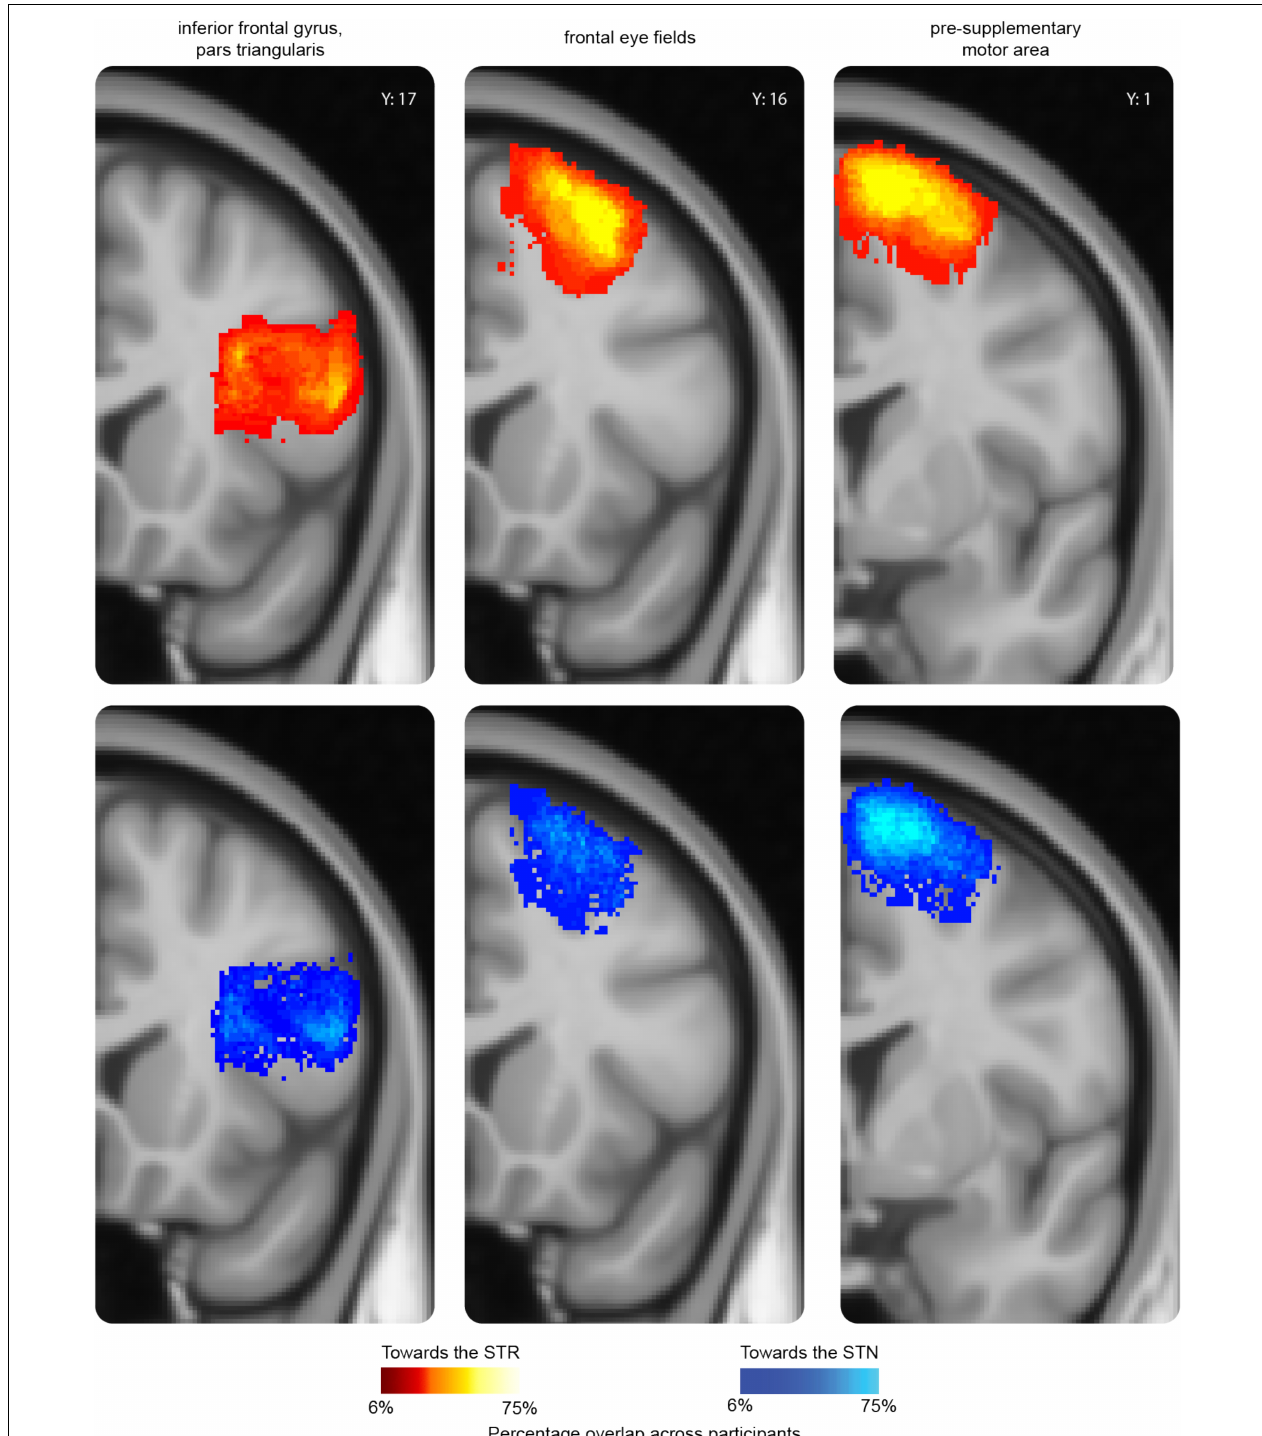
FIGURE 3 | A probability map of three representative cortical regions projecting to the subcortex. For the pars triangularis (PTR), frontal eye fields (FEF), and pre-supplementary motor area (pre-SMA), a probability map was created using the individual thresholded seed masks. The thresholded seed masks only include those voxels which contained at least 50 samples in the tractography analysis. To be able to compare the results across participants, the thresholded seed masks were transformed back into MNI-standard space using the inverted transformation matrices. The color intensity indicates the overlap across participants. In red-yellow the probability map of the thresholded seed masks toward the STR; in blue the probability map of the thresholded seed masks toward the STN. The y value corresponds to the MNI coordinate system.